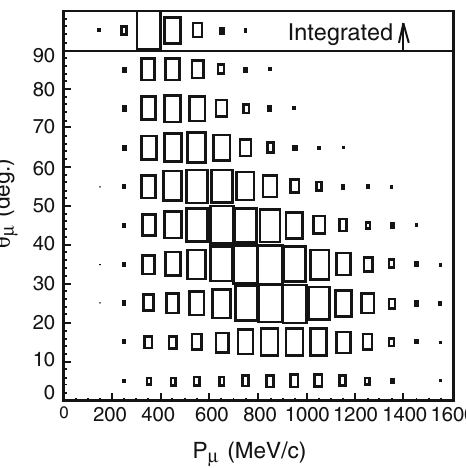
Fig. 25 The observed p μ , θ μ distribution for FC1R μ events in 1KT